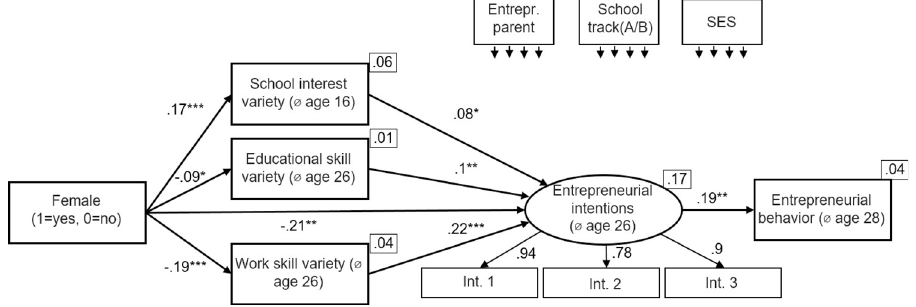
Fig 6. Seemingly unrelated regression model with entrepreneurial behavior succeeding entrepreneurial intentions. Standardized coefficients are given. R 2 is shown in the upper right corner of the dependent variables. Correlations between the control variables and between the mediators were allowed. � p < .05; �� p < .01; ��� p < .001.